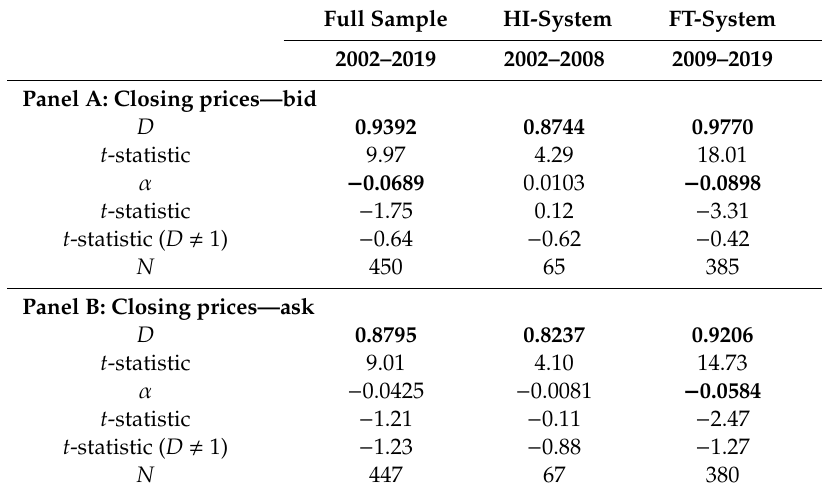
Table A2. Price-drop ratio on the ex-date (bid and ask